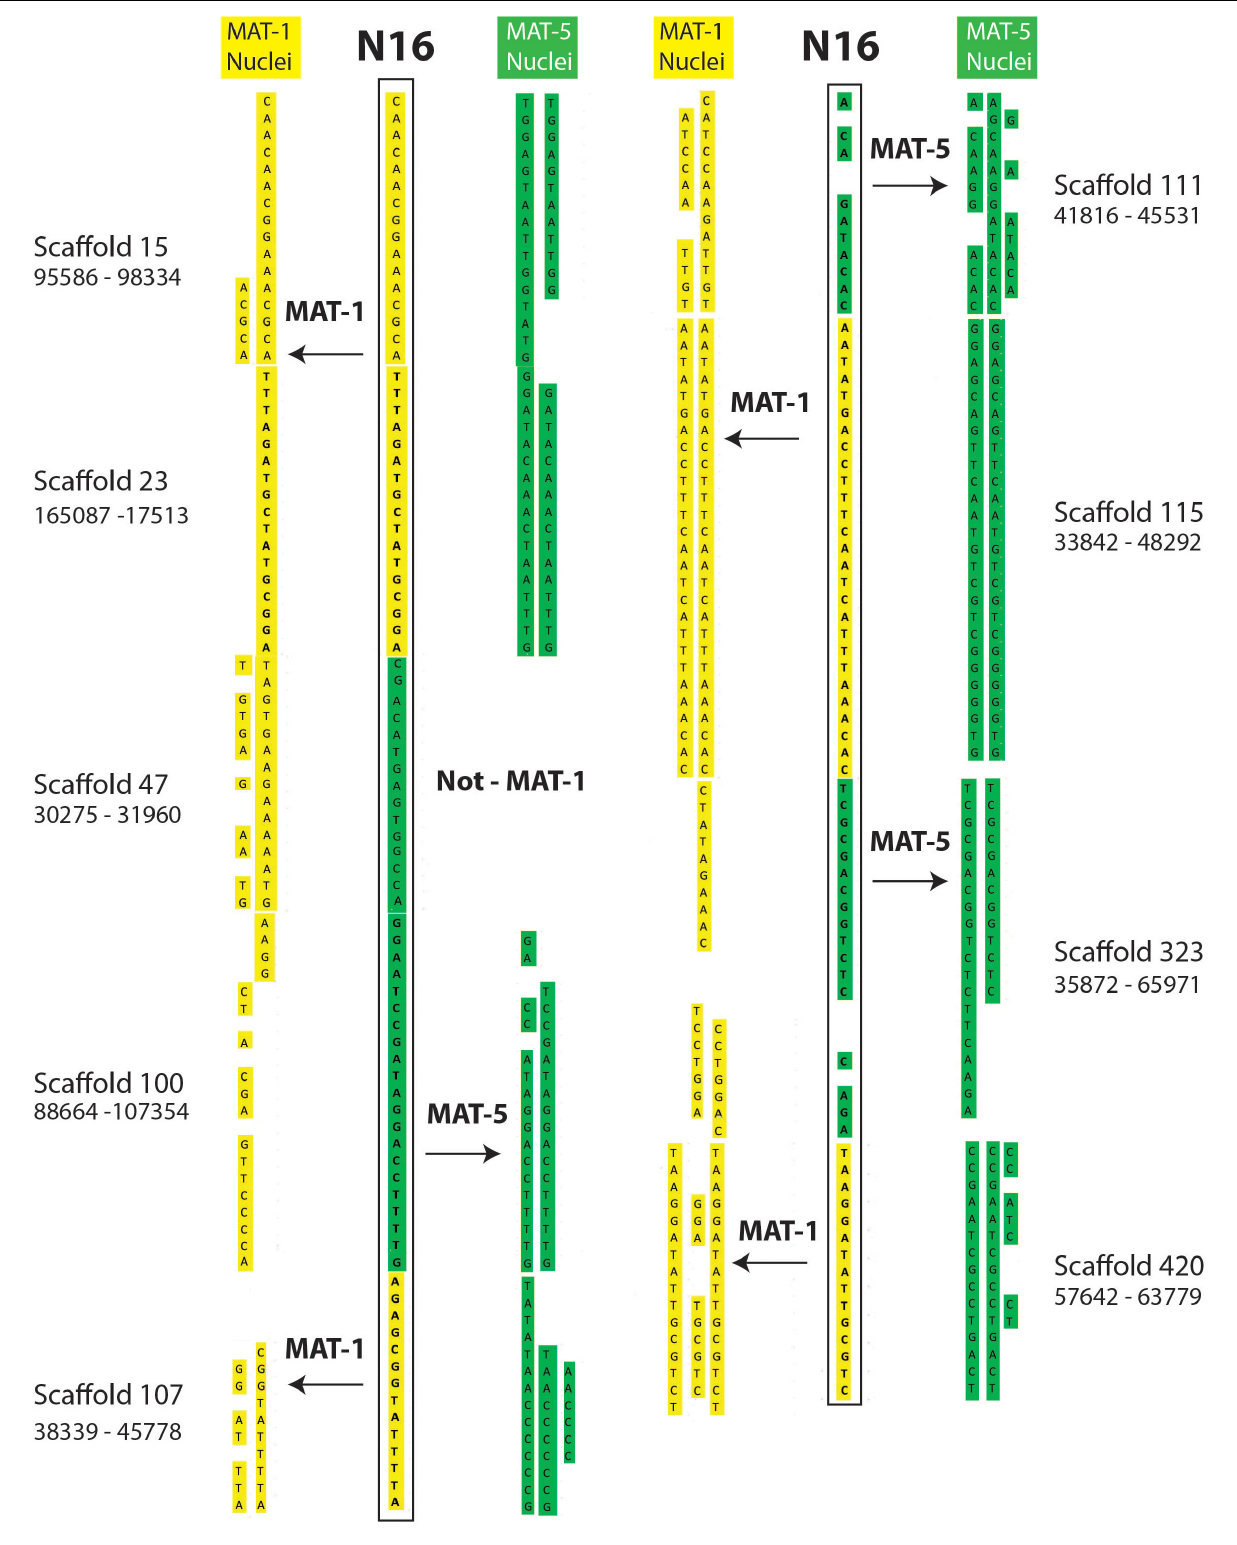
Frontiers in Plant Science |